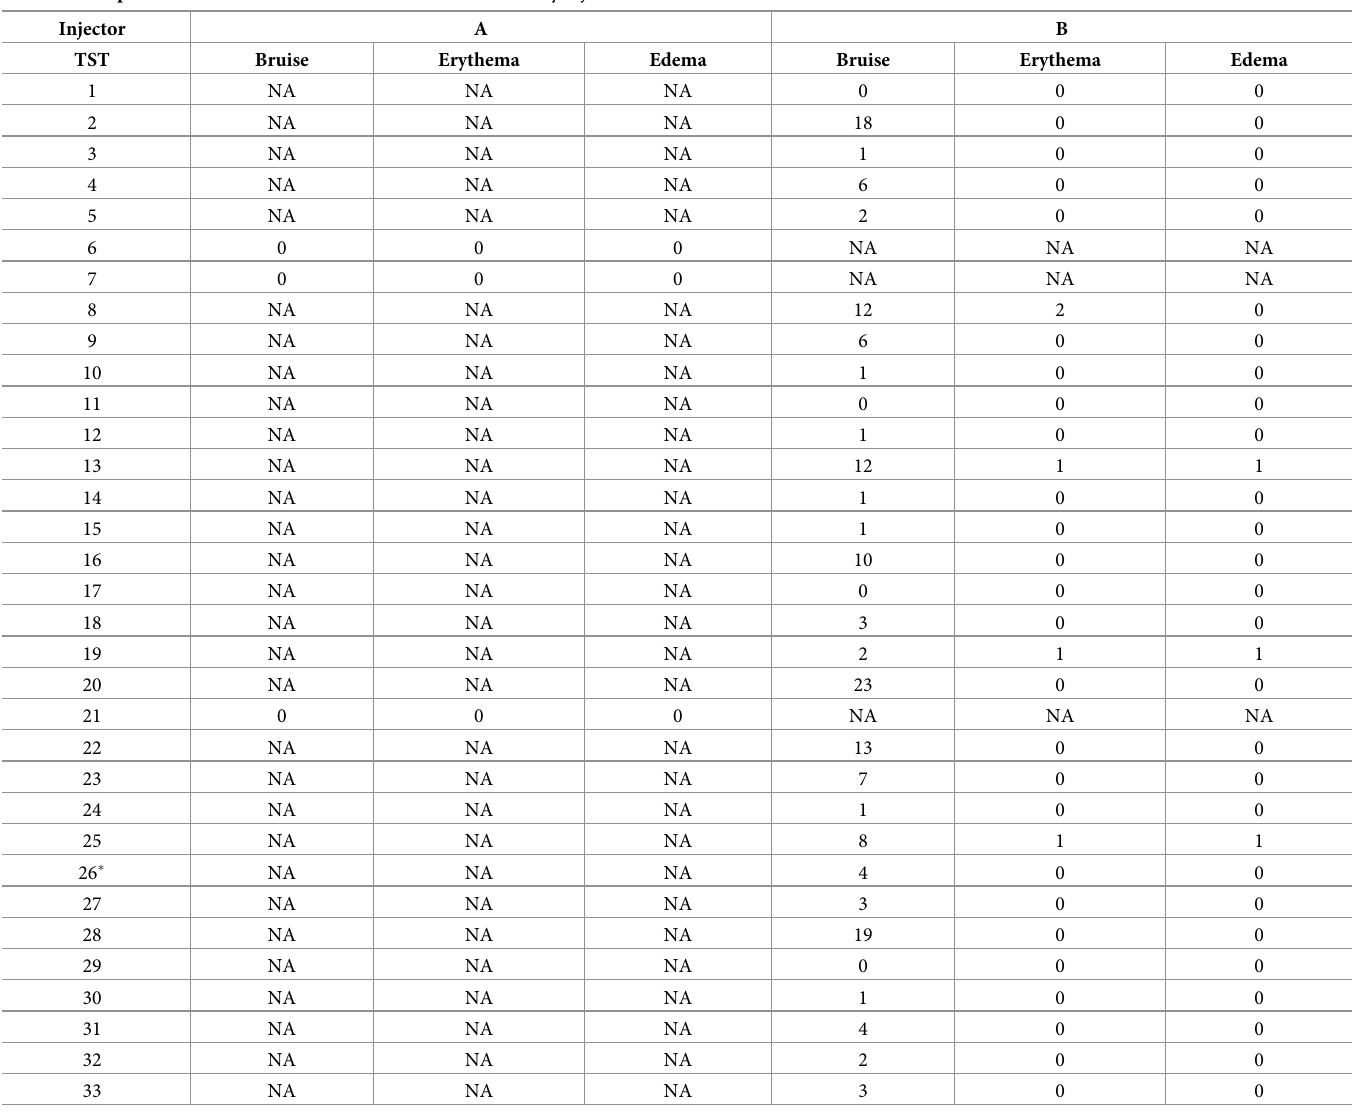
Table 4. Comparison of all animal reactions to MOT at 72 hours by